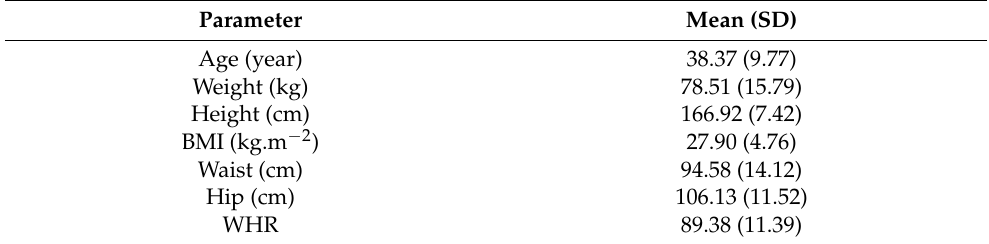
Table 2. Statistical description of anthropometric parameters at baseline level (n = 75).